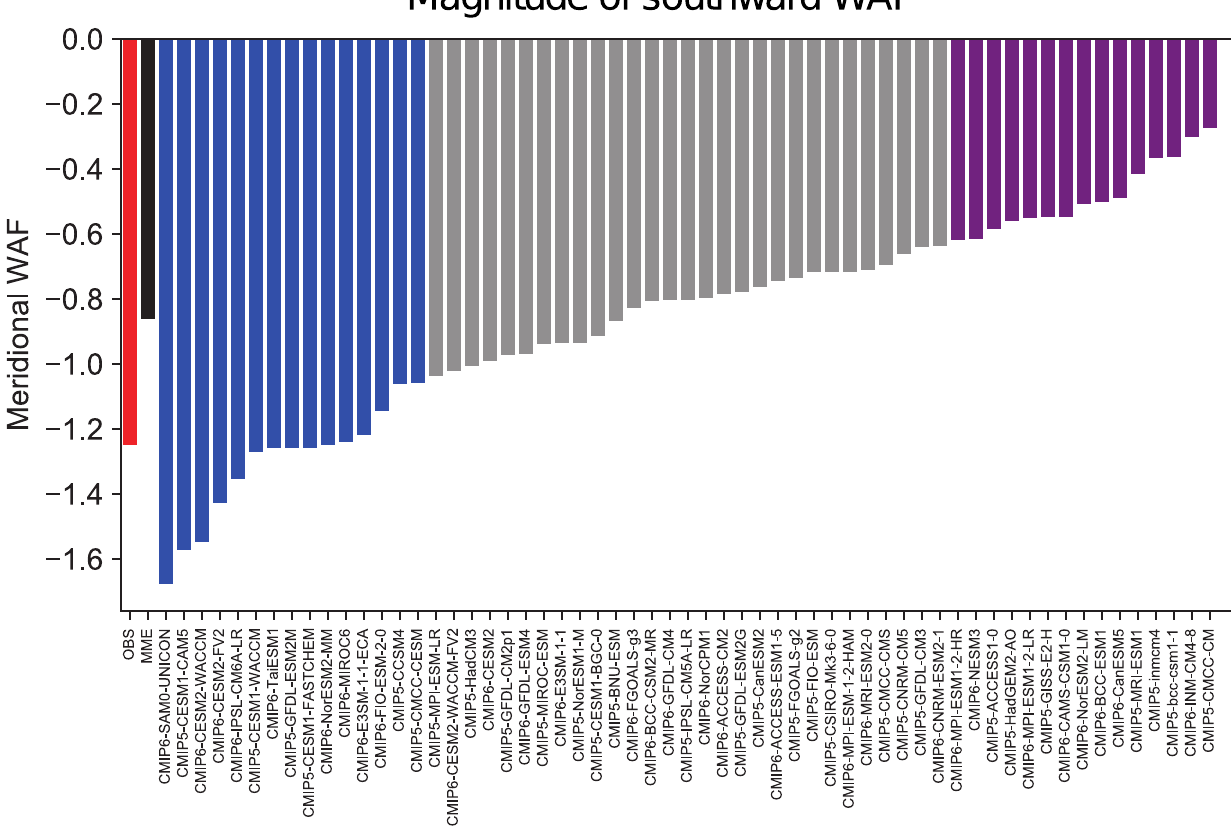
Fig. 2 Magnitude of southward WAF averaged over 160°E – 140°W, 5°N – 20°N for the observation, 59 CMIP5/6 models, and their ensemble mean. Southward WAF is averaged over 160°E – 140°W, 5°N – 20°N for all NPO events based on a threshold of 0.5 standard deviations. The red bar represents the observational southward WAF. The blue (purple) bars represent the strong (weak) MWAF group, whereas the gray bars represent the rest of the models. Both the strong and weak groups have 15 members of